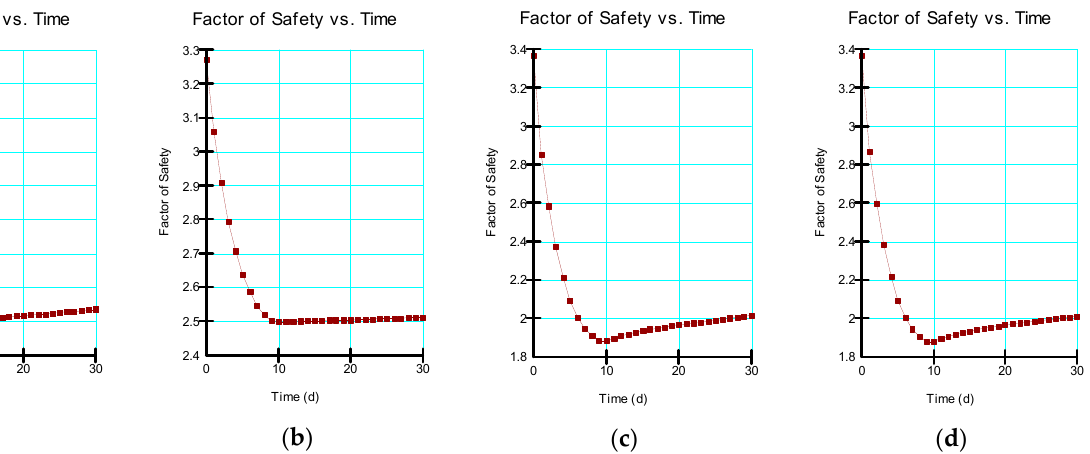
Figure 9. Drawdown over 10 days: ( a ) normal operating reservoir level, ( b ) reduced operating res- ervoir level, ( c ) embankment height operating reservoir level, ( d ) overflow operating reservoir level.